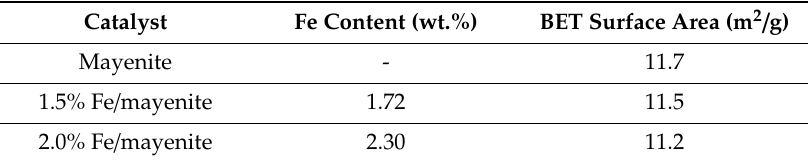
Table 1. Iron content and BET surface area of the